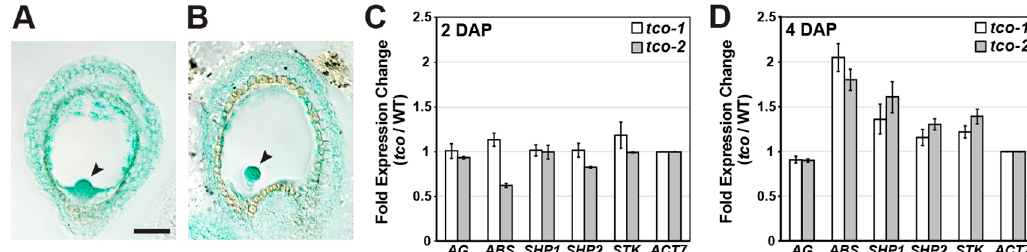
Figure 5. TCO is expressed throughout the Arabidopsis seed where it affects MADS-box gene expression. ( A , B ) Expression of TCOp::TCO-GUS in seeds of two independent transgenic lines of Arabidopsis . Note expression throughout the seed coat, endosperm and globular stage embryos (arrowheads). Bars: 50 µ m. ( C , D ) Quantitative RT-PCR on C-class ( AG ) and D-class genes ( ABS , SHP1 , SHP2 , STK ) in tco-1 and tco-2 siliques relative to wild type (WT) at 2 days after pollination (DAP) ( C ) and 4 DAP ( D ). Fold expression change ( tco /WT) was normalized against ACTIN7 ( ACT7 ) expression. Data are represented as mean +/ − SE of two biological replicates.